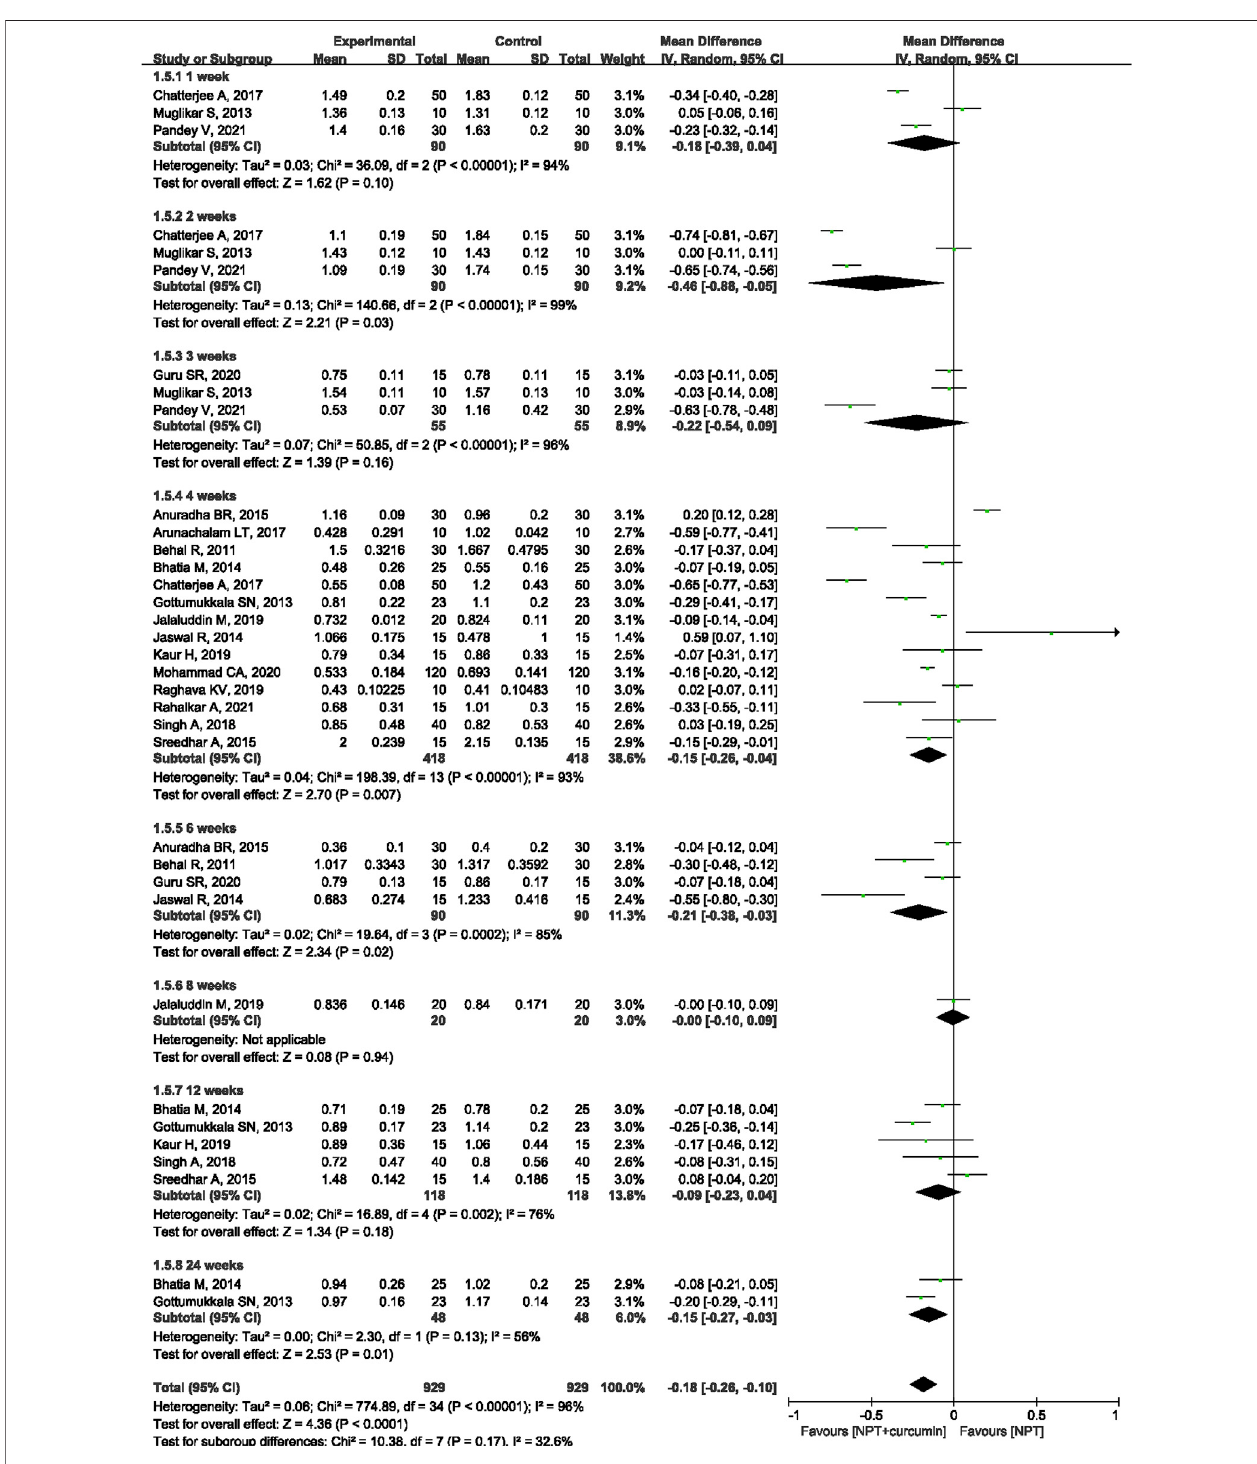
FIGURE 7 | Forest plot of the effects of curcumin + NPT versus NPT on PI.